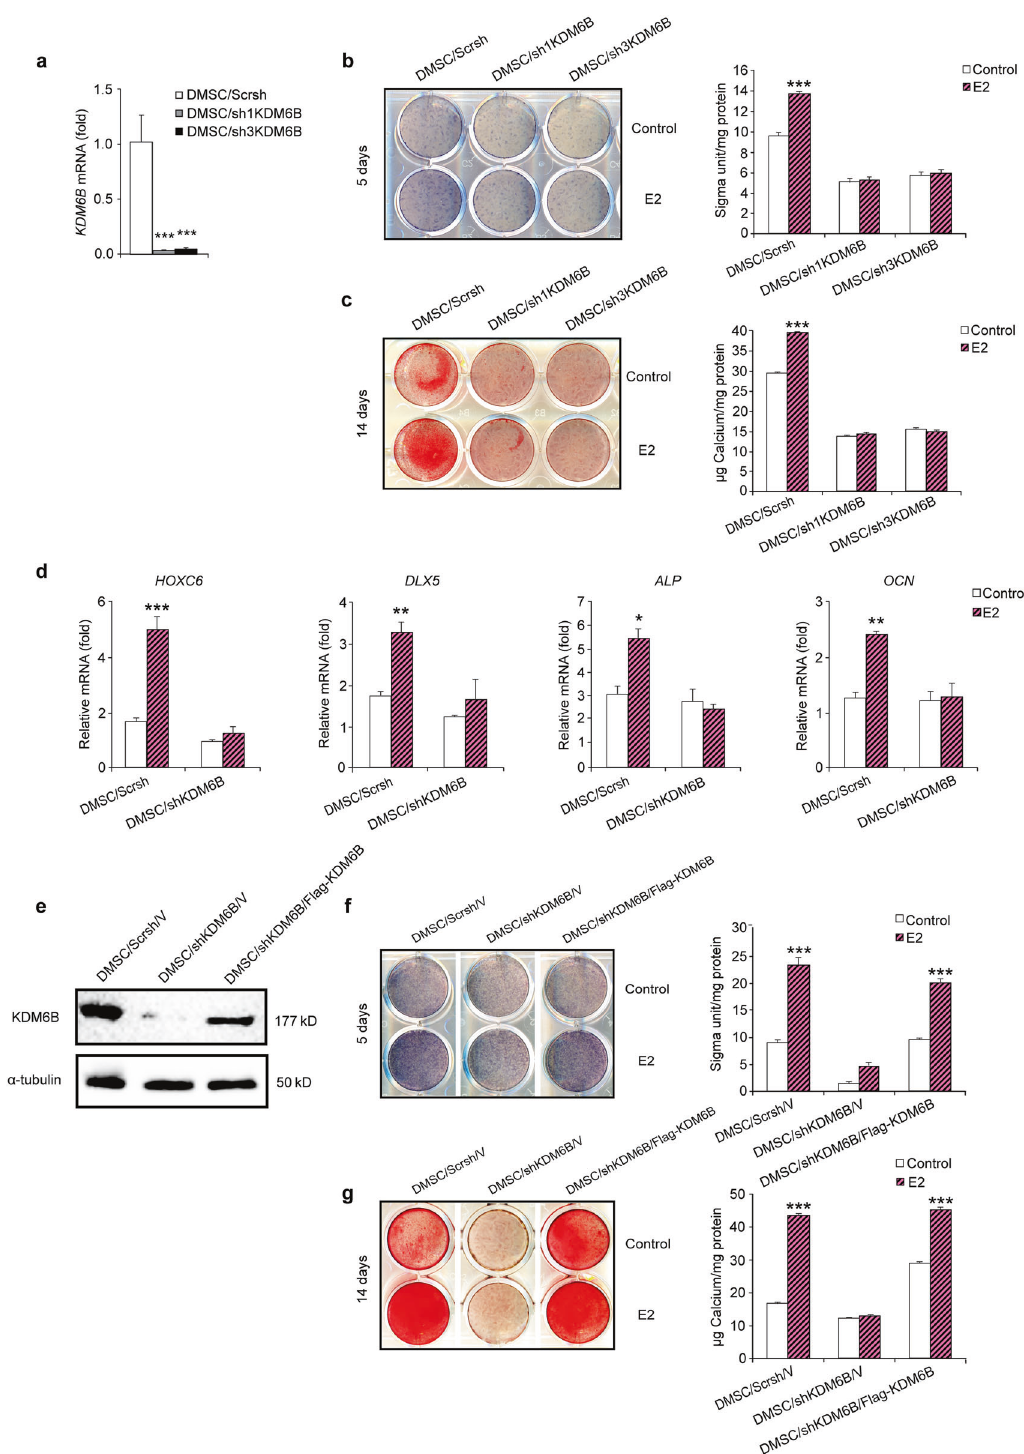
Fig. 2 KDM6B is critical for E2-mediated osteogenic differentiation of DMSCs. a Depletion of KDM6B in DMSCs via two different shRNAs ( sh1KDM6B and sh3KDM6B ) by qRT-PCR. b Alkaline phosphatase staining and quanti fi cation of KDM6B-depleted DMSCs after 5 days in osteogenic media with and without E2. c Alizarin Red S staining and quanti fi cation of KDM6B-depleted DMSCs after 14 days in osteogenic media with and without E2. d qRT-PCR of osteogenic genes ( HOXC6, DLX5, ALP, OCN ) in the KDM6B-depleted DMSCs following osteogenic media induction with and without E2. e Overexpression of KDM6B in KDM6B-depleted DMSCs con fi rmed by western blot analysis. f Alkaline phosphatase staining and quanti fi cation of DMSC/ Scrsh/ V, DMSC/ shKDM6B /V, and DMSC/ shKDM6B /Flag- KDM6B . g Alizarin Red S staining and quanti fi cation of DMSC/ Scrsh /V, DMSC/ shKDM6B /V, and DMSC/ shKDM6B /Flag- KDM6B . Data are presented as the mean ± SEM ( n = 3). For a and d , data are shown as fold expression of target genes after normalization to DMSC/ Scrsh . For a , the groups with shKDM6B were compared with Scrsh by using one-way ANOVA with Tukey ’ s post hoc test. For b , c , d , f and g , all the groups were compared by two-way ANOVA with a Bonferroni post hoc test. Asterisks were assigned to P values with statistical signi fi cance (* P < 0.05; ** P < 0.01; *** P <